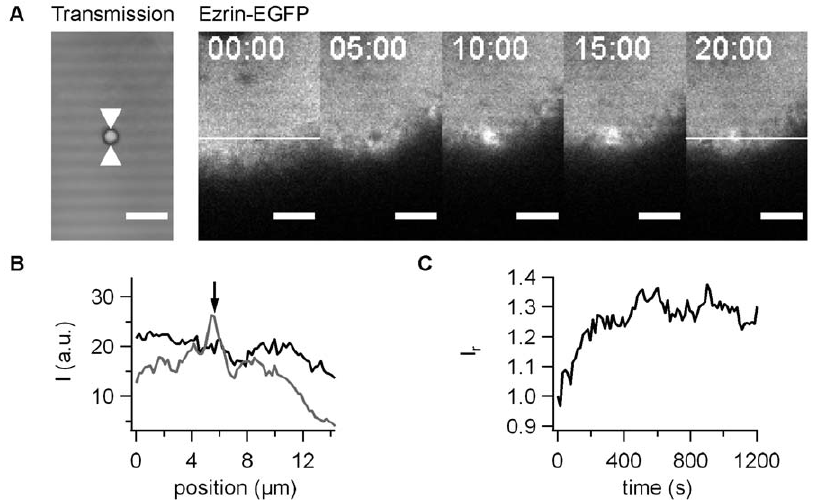
Figure 3. Dynamics of ezrin-EGFP accumulation with pilus coated beads. A) One confocal plane of ezrin-EGFP producing epithelial cells was monitored during 20 min. Scale bar 5 m m. B) Intensity plot through the ROI shown in A) at black: 0 min, grey: 20 min post adhesion. C) I r as a function of time for the time lapse in A).